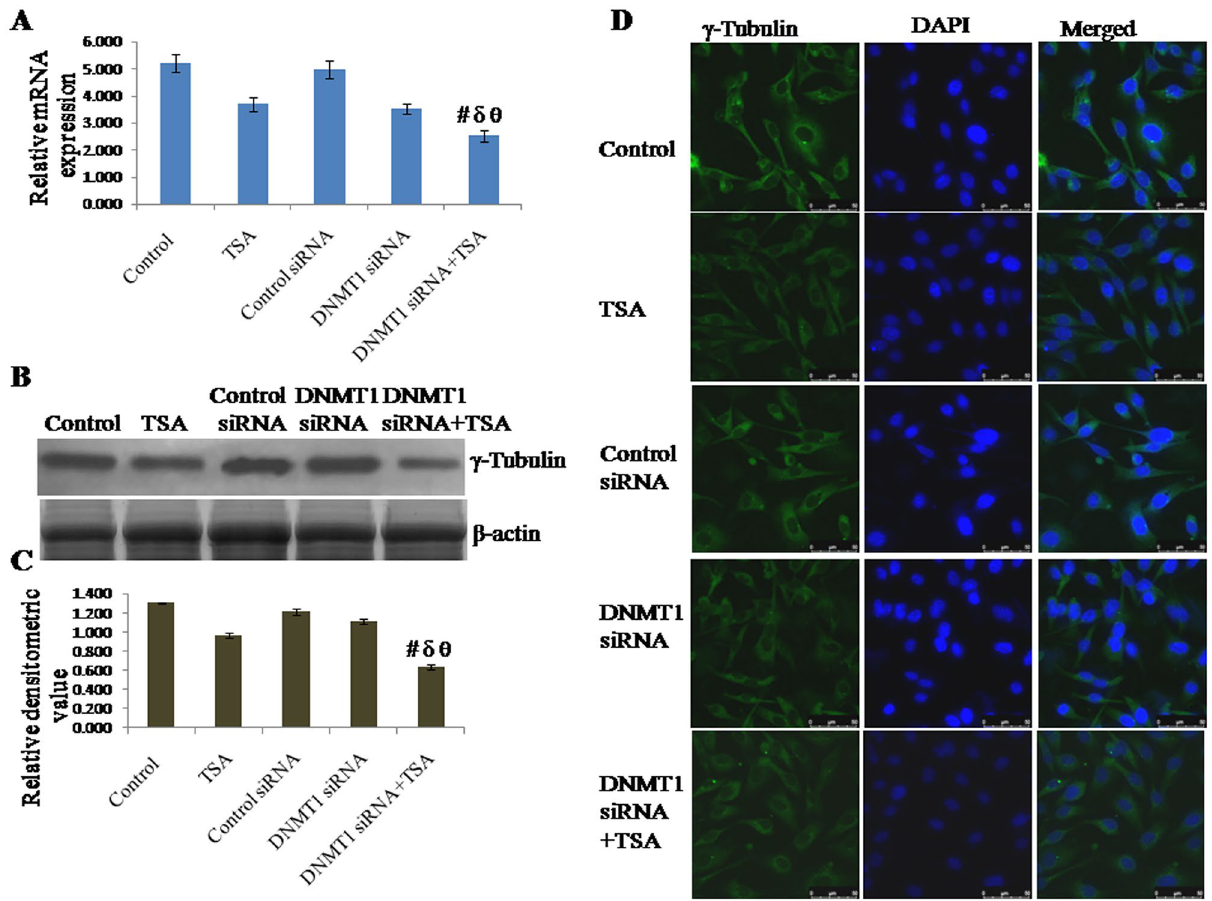
Figure 2. Expression of γ-Tubulin analyzed by ( A ) qRT-PCR using GAPDH as internal control and expressed in terms of relative mRNA expression, ( B , C ) Western blotting using β-actin as internal control and expressed in terms of relative densitometric value, ( D ) immunofluorescent staining and confocal microscopy to observe cellular localization of γ-Tubulin. The representative blots of replicates were presented here. The full-length original images (cropped) of representative blots were presented in the supplementary Fig. S3 of Supplementary information file. Data was represented as mean ± SEM., n = 3, p < 0.05. #, δ and θ represent; compared to control group, TSA treated group and DNMT1 siRNA transfected group